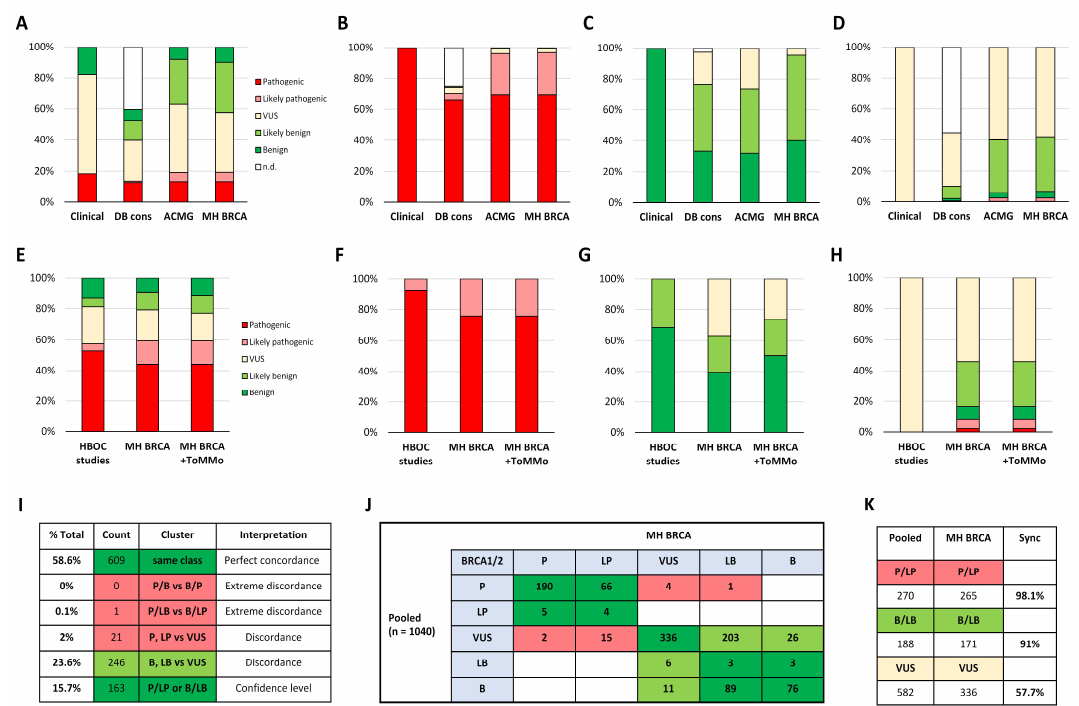
Figure 2. Impact of Japanese genomic cohort data evaluated in datasets of Japanese HBOC studies. ( A ) ACMG-guided classifications of 838 unique BRCA1 / 2 variants collected from the study of Momozawa et al. [15] were compared to MH BRCA on the level of database consensus, ACMG-guided calculation and consolidated interpretation. Classification based on a 3 or 5-Tier system is shown in percentage. ( B ) Cluster analysis of 154 pathogenic classified variants. ( C ) Cluster analysis of 150 benign classified variants. ( D ) Cluster analysis of 534 VUS classified variants. ( E ) Classifications of 202 BRCA1 / 2 variants were pooled together from three Japanese HBOC studies [12–14] and were compared to MH BRCA with or without the Japanese genomic cohort data of ToMMo. Classification based on the 5-Tier system is shown in percentage. ( F ) Cluster analysis of pooled pathogenic and likely pathogenic classified variants ( n = 116), ( G ) cluster analysis of pooled benign and likely benign classified variants ( n = 38), ( H ) cluster analysis of pooled VUS classified variants ( n = 48). ( I ) Merged classifications of 1040 BRCA1 / 2 variants from four Japanese HBOC studies. ( J ) Blotted classification-matrix illustrates concordance (green) and discordance a ff ecting clinical decisions (red). ( K ) Percentage of concordance in each cluster. Abbreviations: P = pathogenic; LP = likely pathogenic; VUS = variant of unknown significance; LB = likely benign; B =